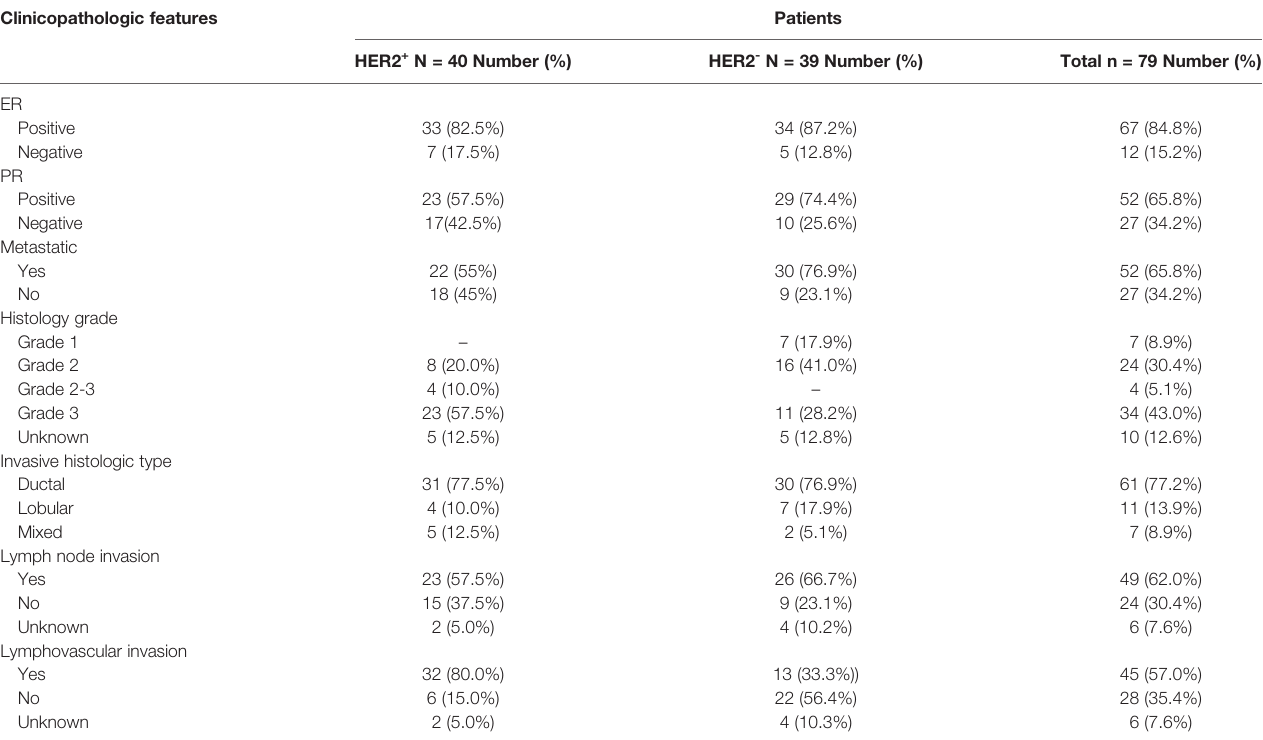
TABLE 4 | Patient clinicopathologic